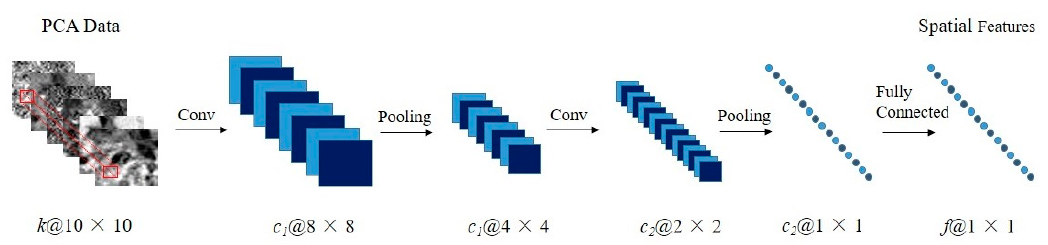
Figure 2. Framework of the proposed CNN-based model for spatial feature extraction. The illustration below each data shows the dimension of the data. For example, a@m × n indicates that the data has channels, and the height and width of the data are m and n, respectively.